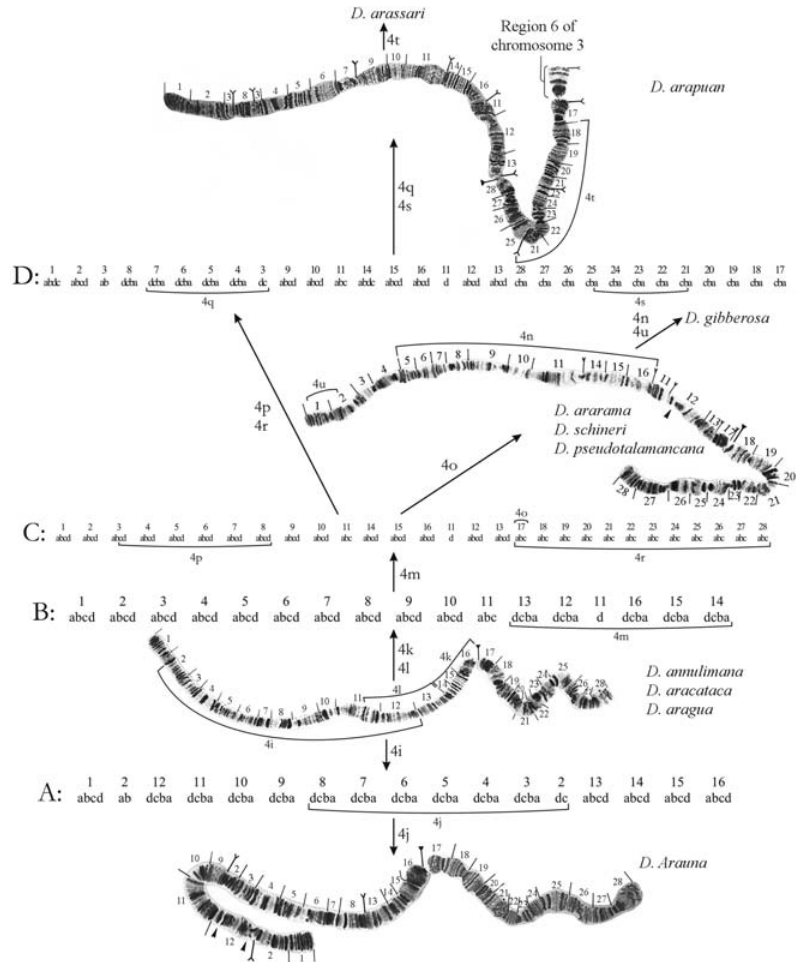
Figure 14 - Relationships among ten Drosophila species of the annulimana group based on the inversions found in chromosome 4. A: hypothetical se- quence: homozygous inversion 4i. B: hypothetical sequence: homozygous inversions 4k and 4l. C: hypothetical sequence: homozygous inversions 4k, 4l and 4m. D: hypothetical sequence: homozygous inversions 4k, 4l, 4m, 4p and 4r. Subdivisions (abcd) have no correspondence in the photomicrographic map and were included to facilitate understanding.